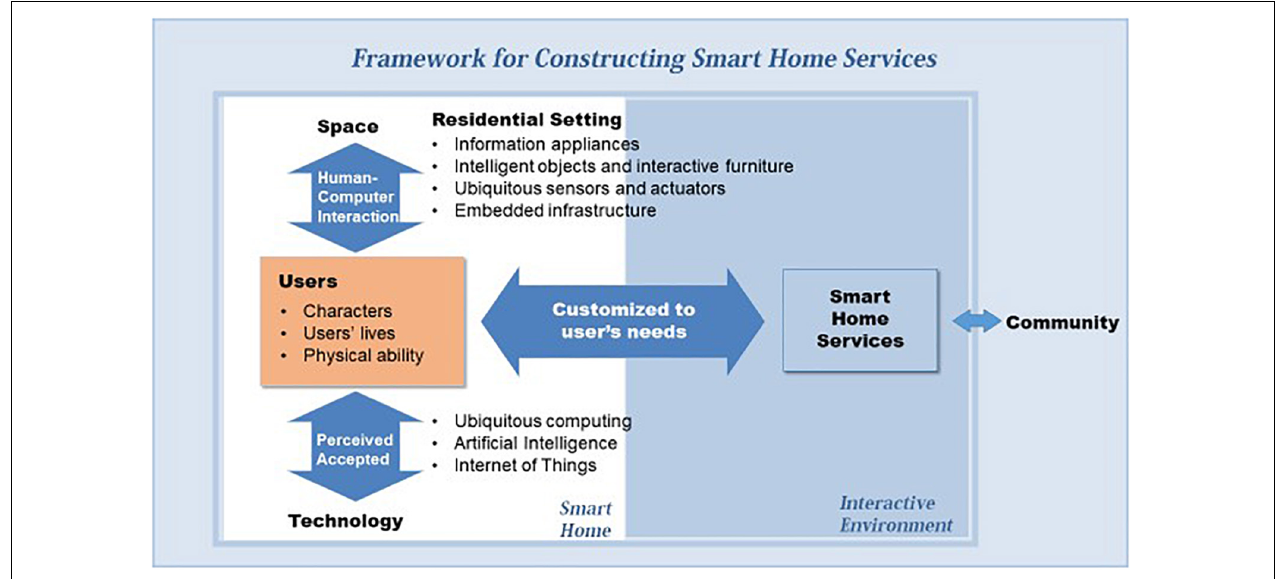
FIGURE 1 | Framework for constructing smart home